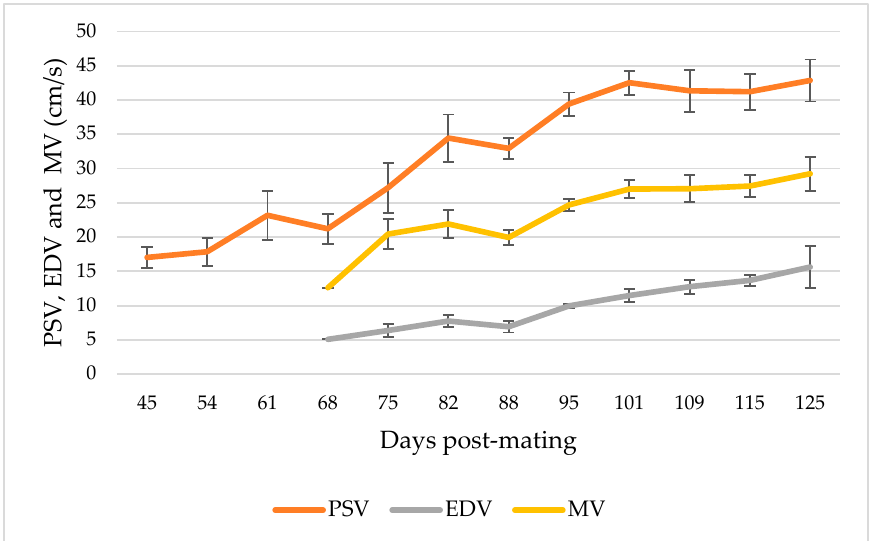
Figure 5. Evolution curves of Peak Systolic Velocity (PSV), End Diastolic Velocity (EDV) and Mean Velocity (MV) in total goats under study ( n : 9). The mean and the standard deviation of the measurements are plotted in relation to the days after mating.